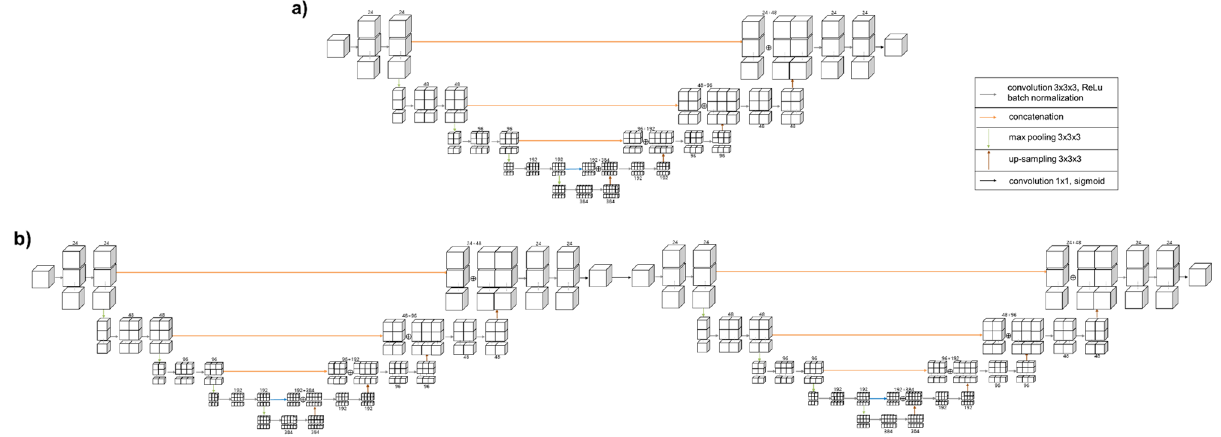
Figure 3. The architecture of ( a ) a basic 3D U-Net and ( b ) a cascaded 3D U-Net.